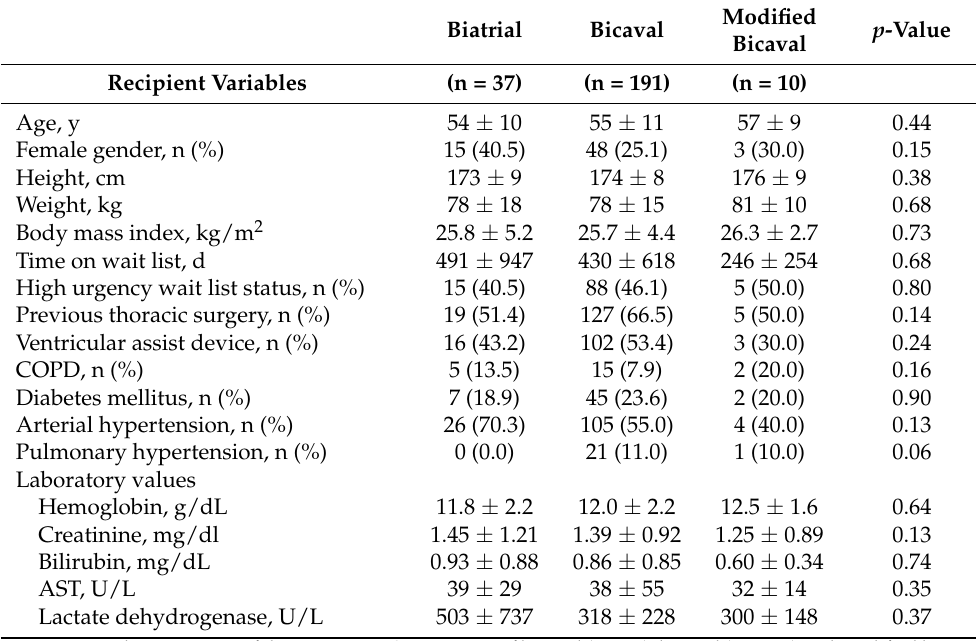
Table 1. Preoperative recipient parameters.